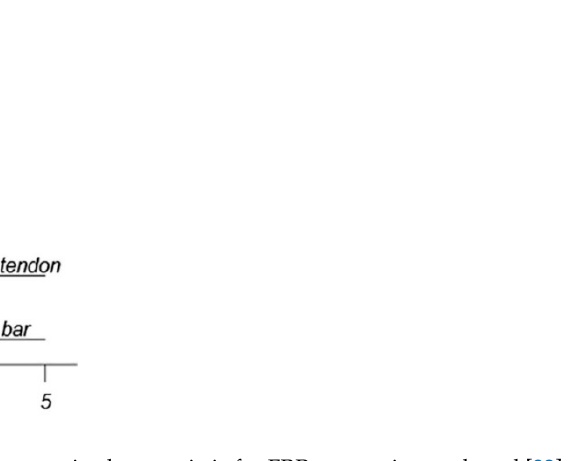
Figure 1. Schematic comparison of stress–strain characteristic for FRP composites and steel [32].